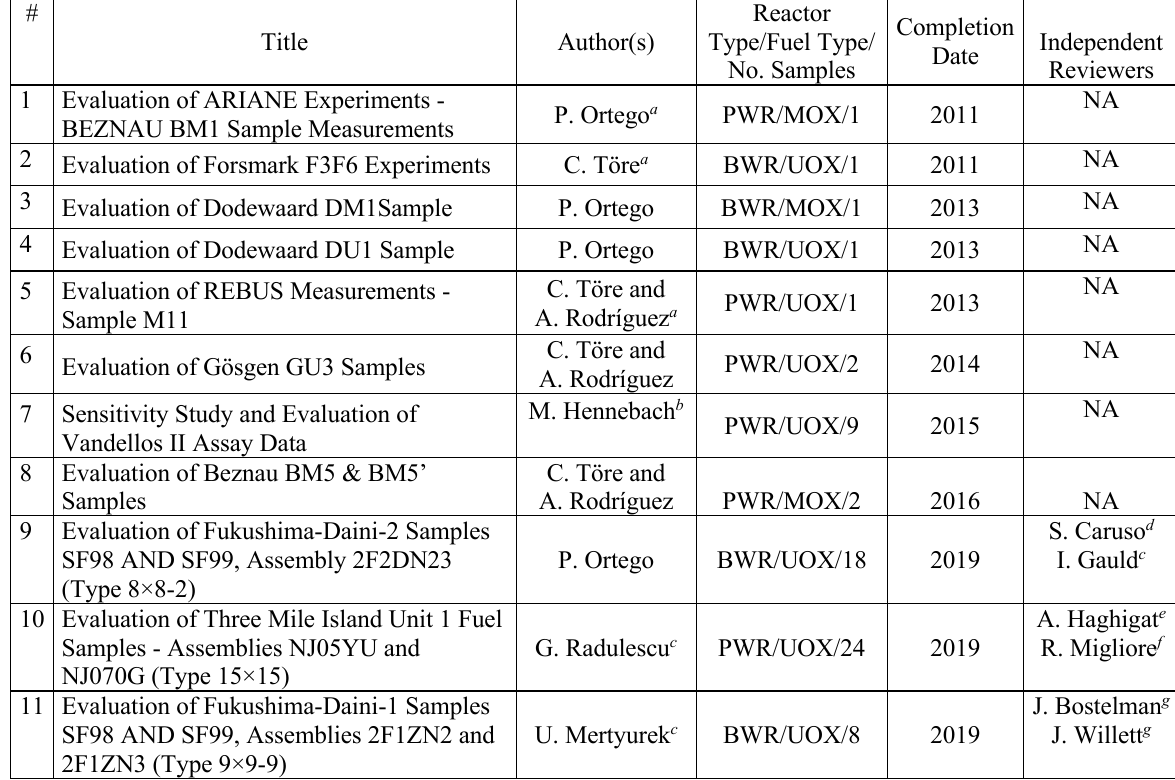
Table I. Draft SFCOMPO evaluations